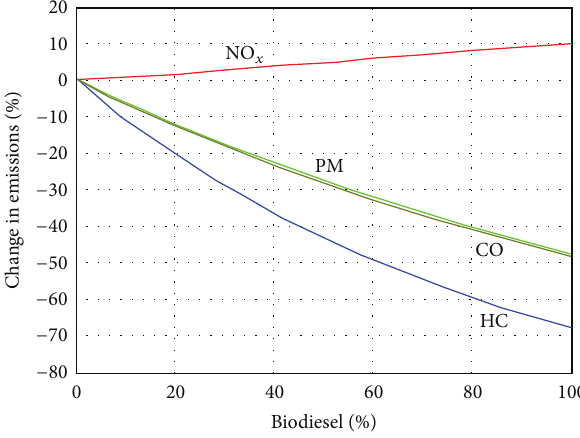
Figure 8: Average emission impact of biodiesel for heavy-duty highway